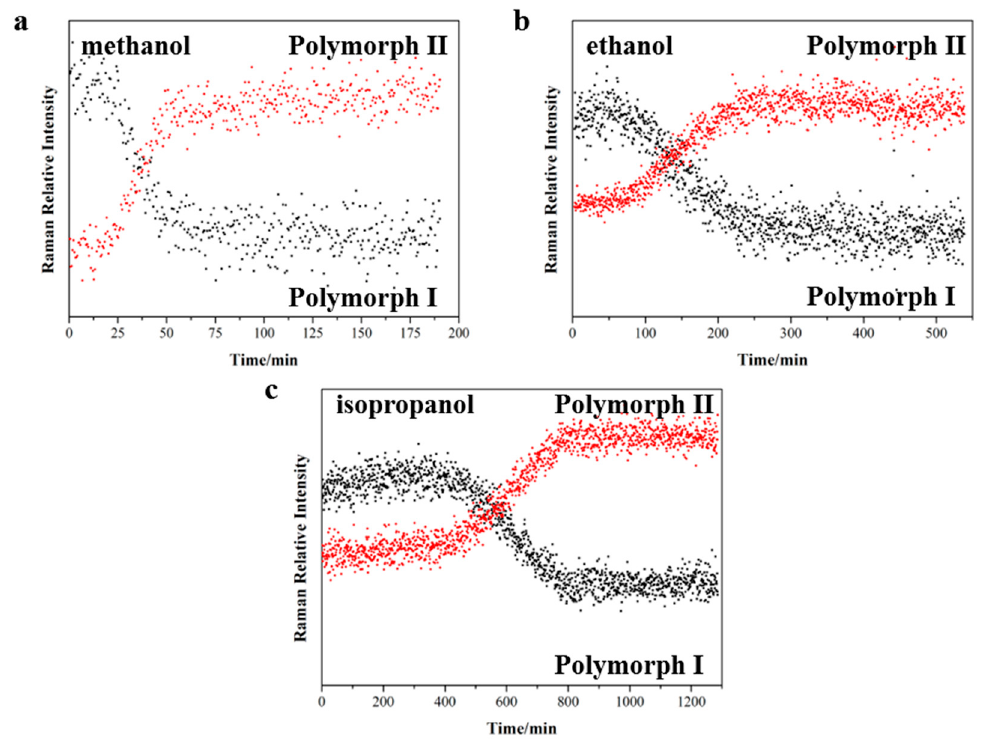
Figure 10. Solution-mediated polymorphic transformation between two polymorphs of theophylline at 30 °C in various solvents. ( a–c ) are profiles of solid composition in methanol, ethanol, isopropanol, respectively.